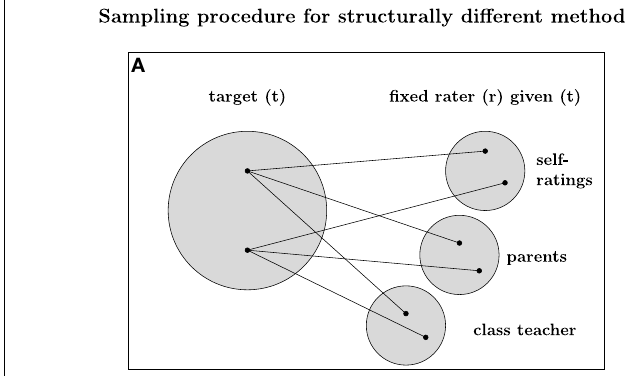
methods (raters). The black filled circles represent possible observation units belonging to the set of targets or raters. Structurally different (fixed) methods are indicated by straight lines connecting raters and targets directly. Interchangeable (random) methods are illustrated by straight lines connecting a target with a particular set of possible raters by a black